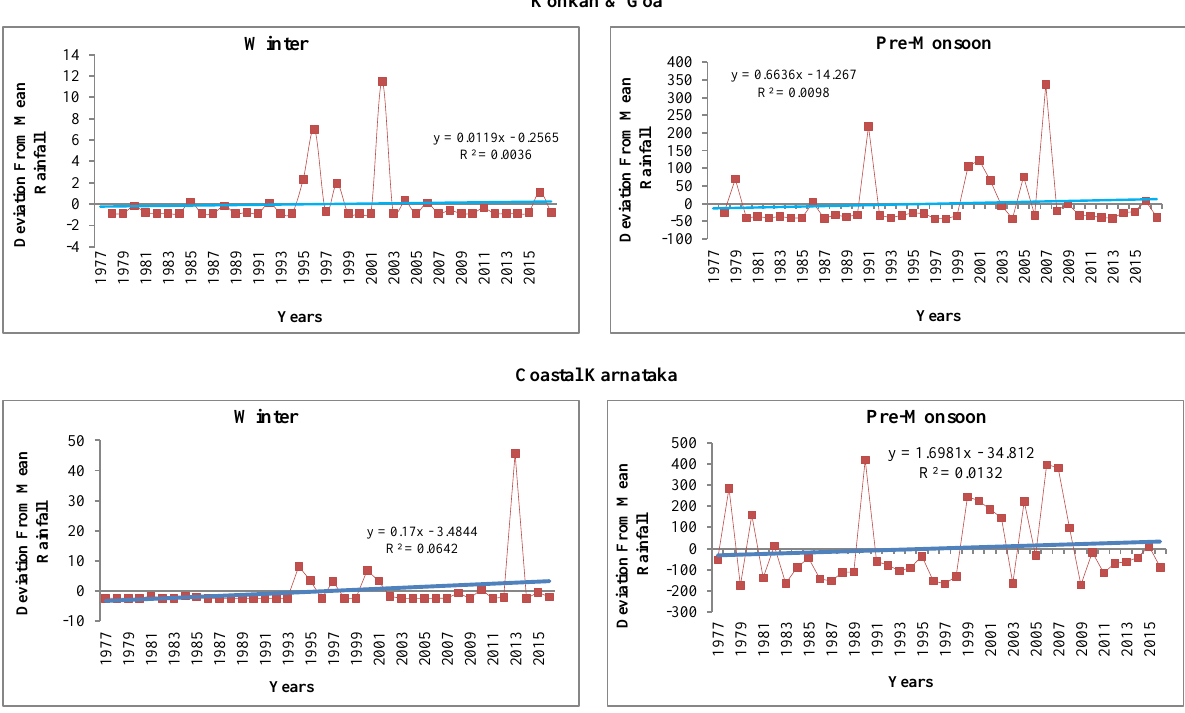
Figure 4. Winter & Pre- Monsoon rainfall trends of both the meteorological sub-divisions